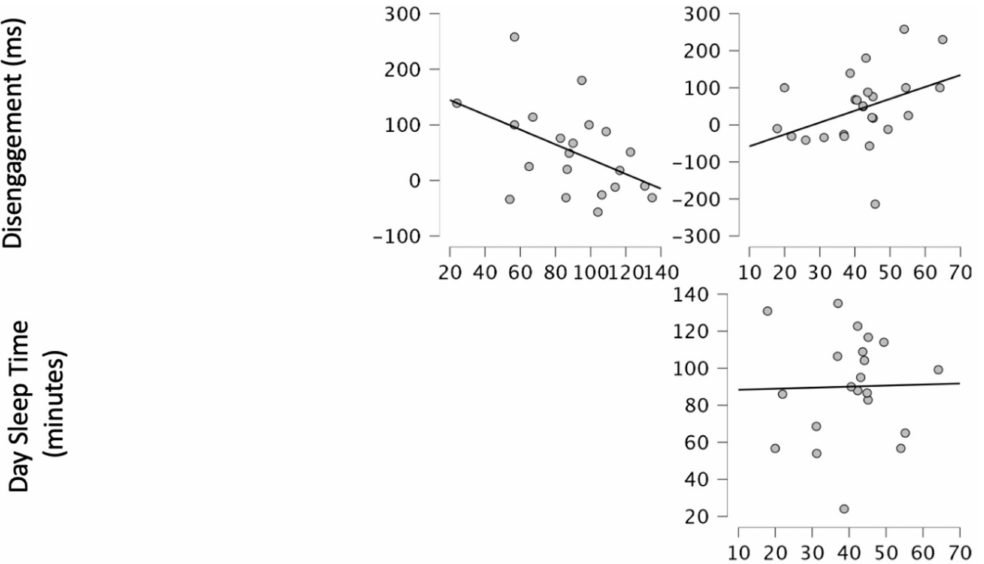
Figure 1. Visualisations of visual attention variables and sleep measures highlighted in the